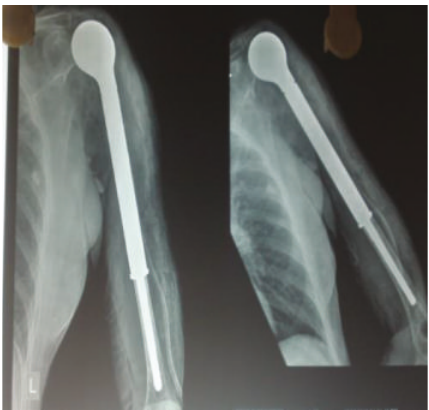
Figure 14: Postoperative radiograph.